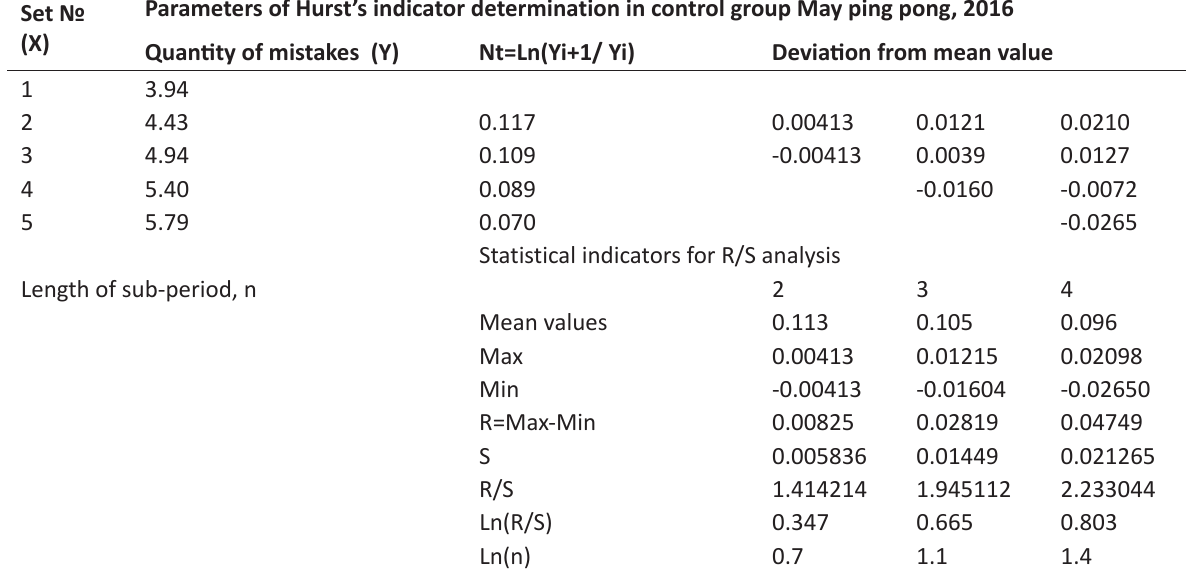
Table 4. Parameters of Hurst’s indicator determination in control group May ping pong, 2016 Set №